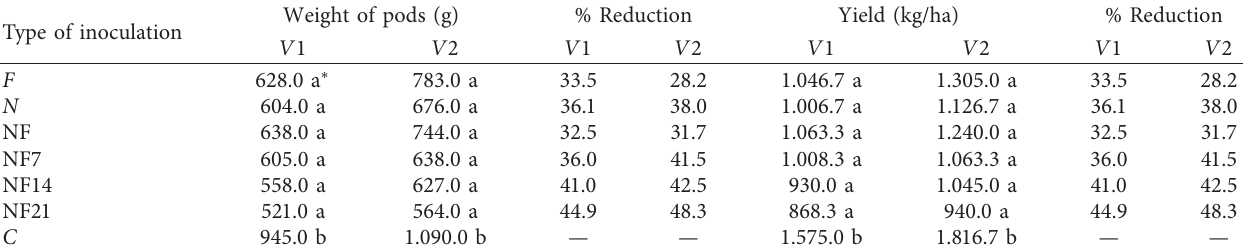
Table 3: Weight of pods and yield for “Essoumtem” and “Clemson spineless” under various inoculations in pot experiment. Type of